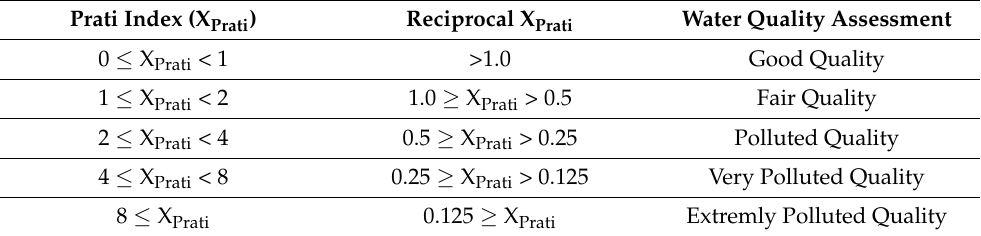
Table 4. Prati index category and its reciprocal form to assess water quality, adopted from